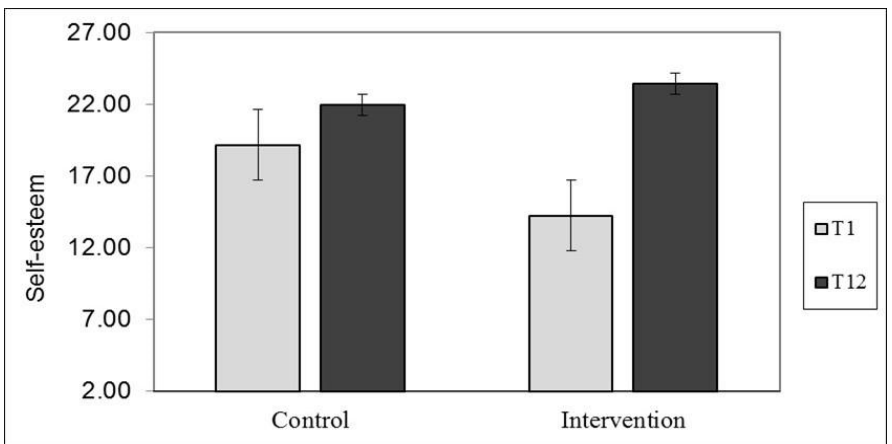
Figure 2. Changes in self-esteem from T1 to T12, as a function of group.